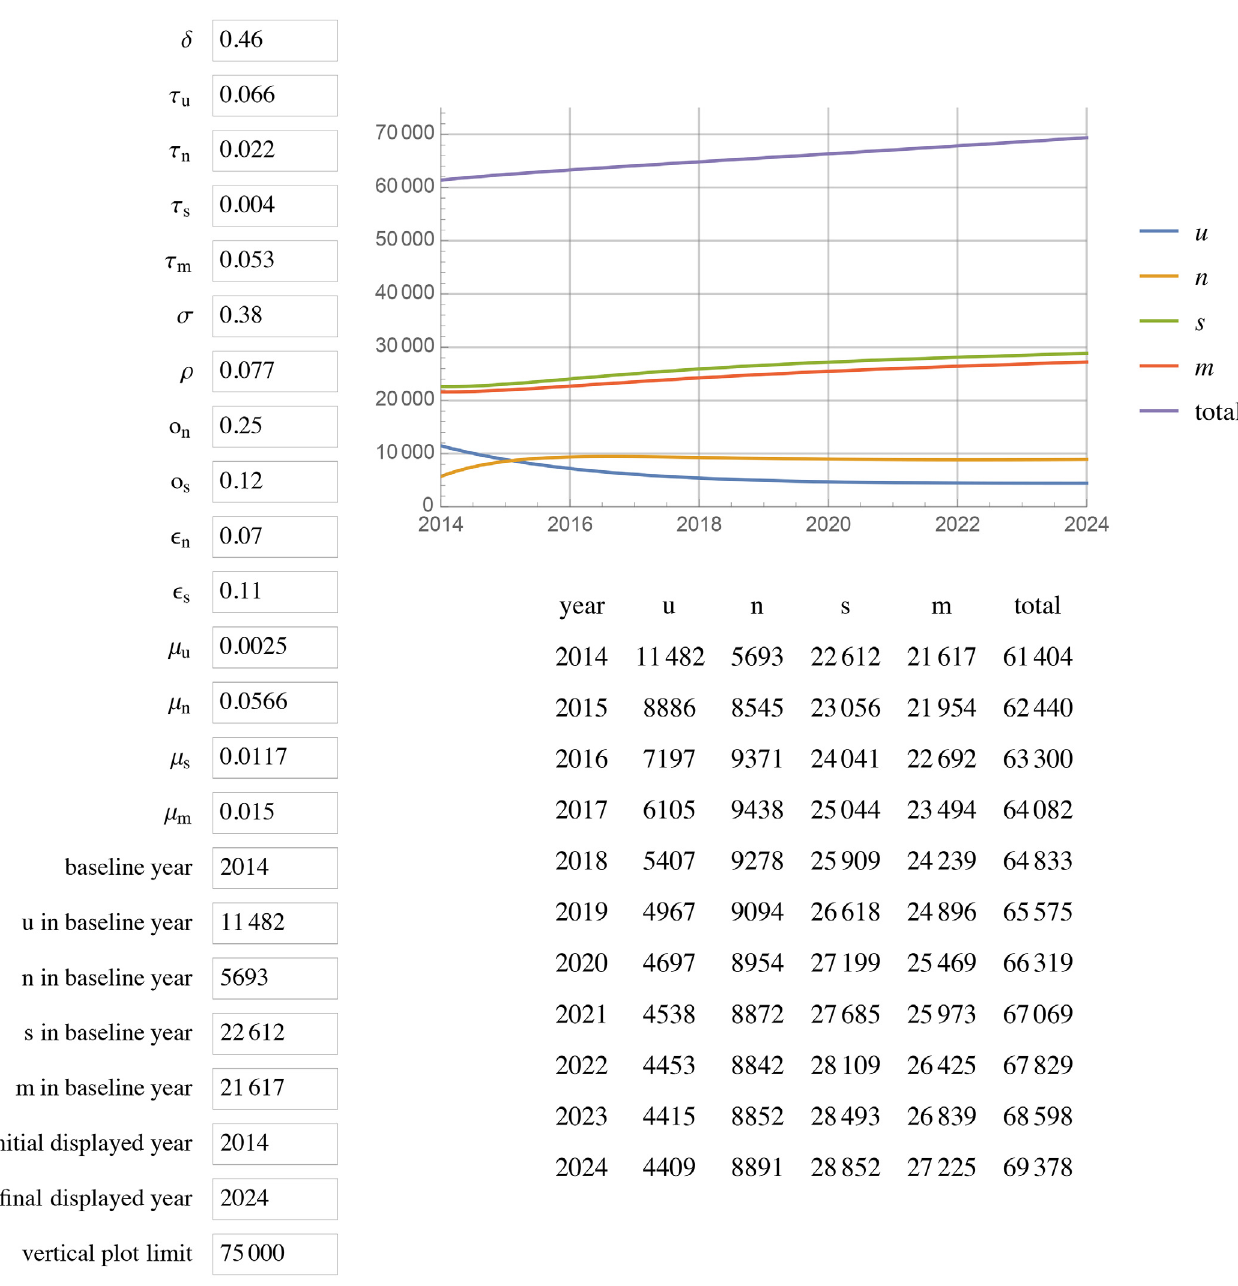
Fig 2. HIV prevalence projections with diagnosis rate doubled to